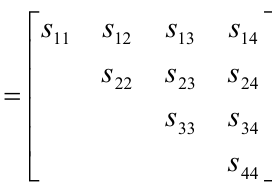
= s when i ≠ j). ij ji